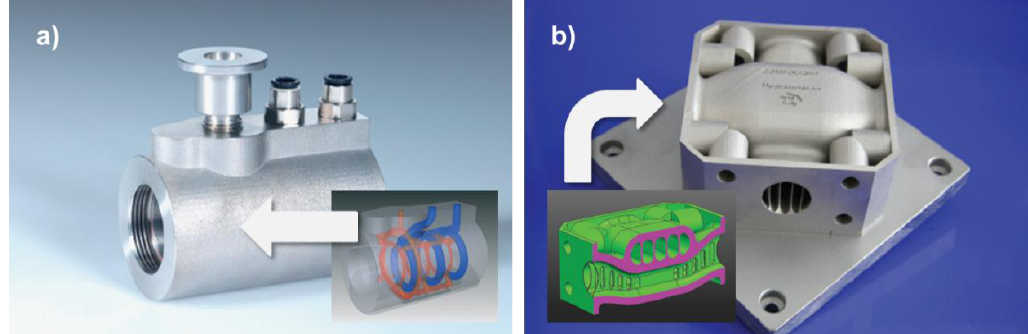
Figure 6. Examples of products and case studies representing major regions of interest of AM technology application: ( a ) A plastic injection molding die featuring conformal cooling channels [70], an example of the Rapid Tooling approach representative of region II and III according to Connor et al. [66] and as depicted in Figure 5; ( b ) low weight, low flow resistance hydraulic crossing [70], region III and IV.